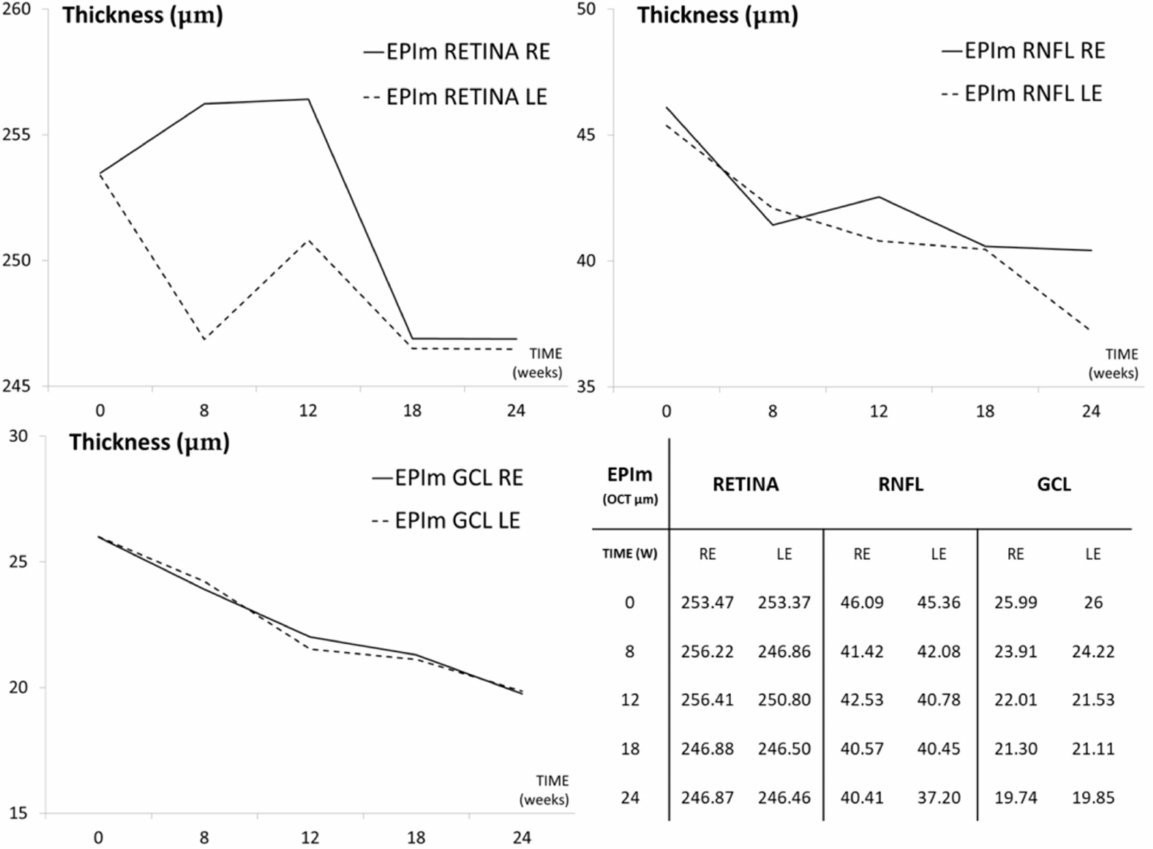
Figure 4. Structural analysis of neuroretina of both eyes by optical coherence tomography under the episcleral model. Abbreviations: EPIm: episcleral sclerosis model; RE: right eye; LE: left eye; OCT: optical coherence tomography; RNFL: retinal nerve fiber layer; GCL: ganglion cell layer; average thickness in microns ( µ